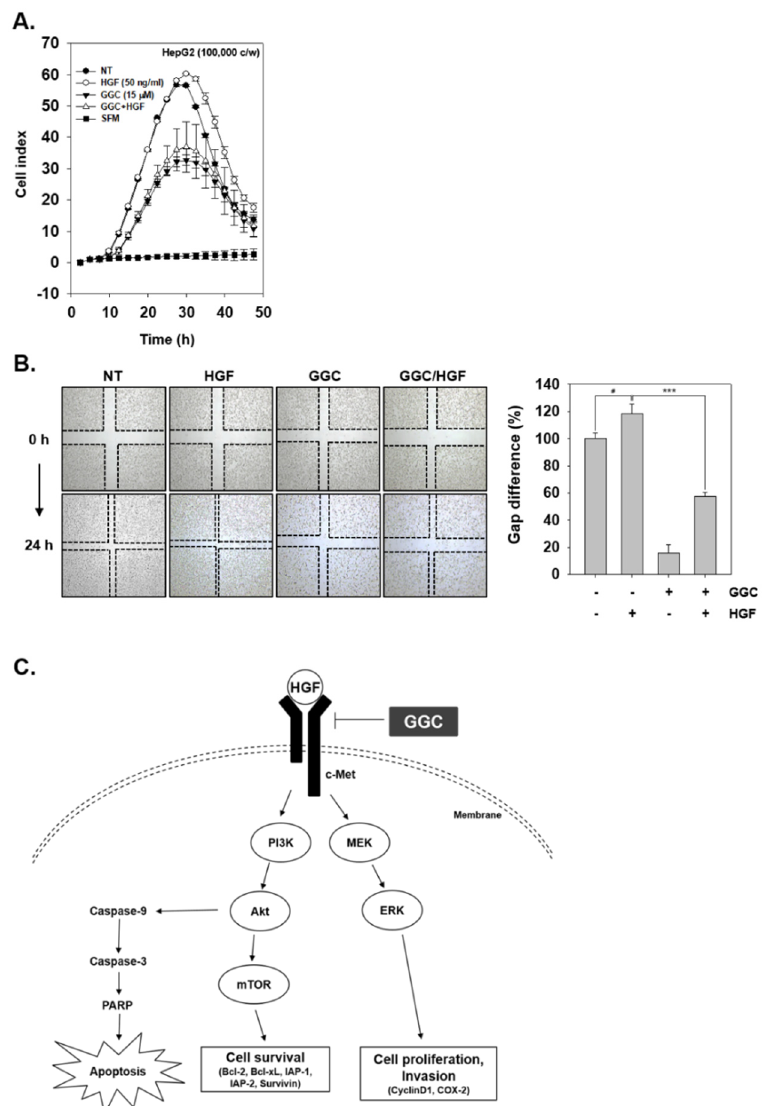
Figure 5. GGC inhibits invasion and migration. ( A ) HepG2 cells were treated with HGF (50 ng/mL), GGC (15 μ M), or combination condition and invasion activity was determined by invasion assay. ( B ) Wound healing assay was used to determine migration. The width of wound was measured at time 0 and 24 h of incubation. Data represent means ± SD. # p < 0.05, *** p < 0.001. ( C ) A schematic diagram showing the effects of GGC on c-Met signaling pathway.